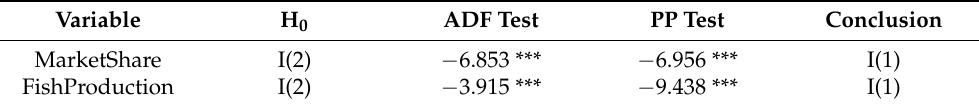
Table 2. Unit Root Tests.